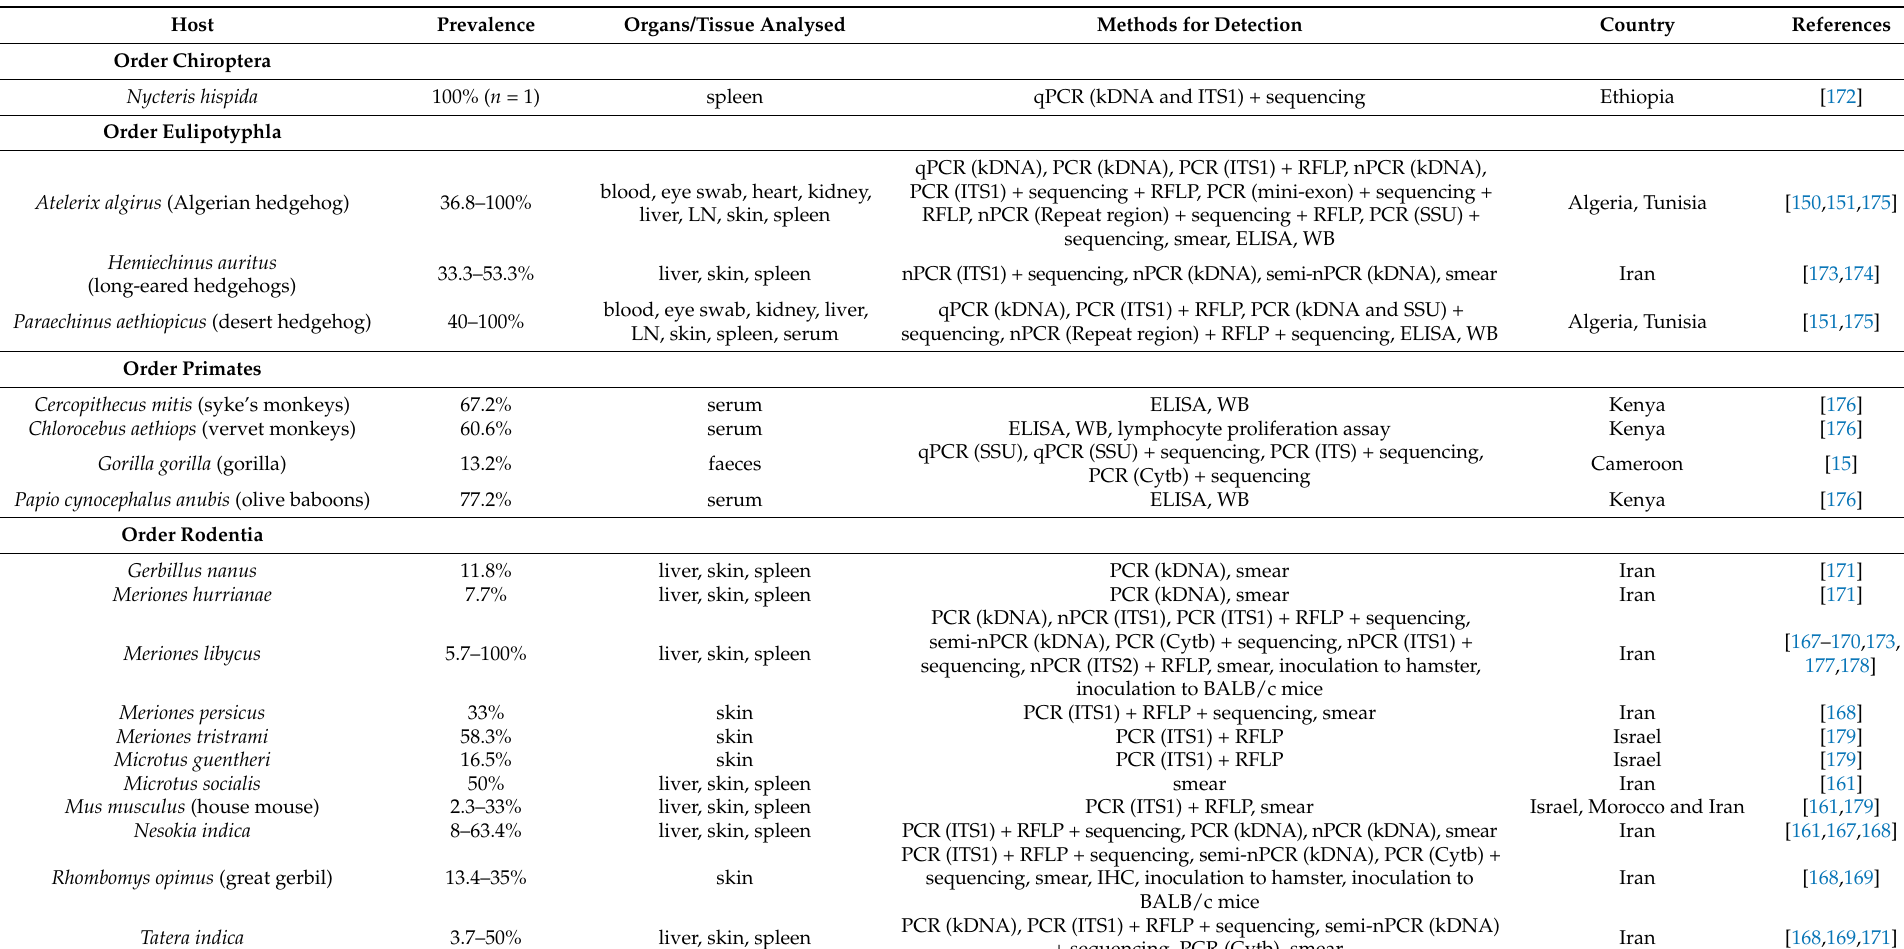
Table 7. Wild animals reported positive for L. major . Organs or tissues where the parasite was detected, and the techniques employed are